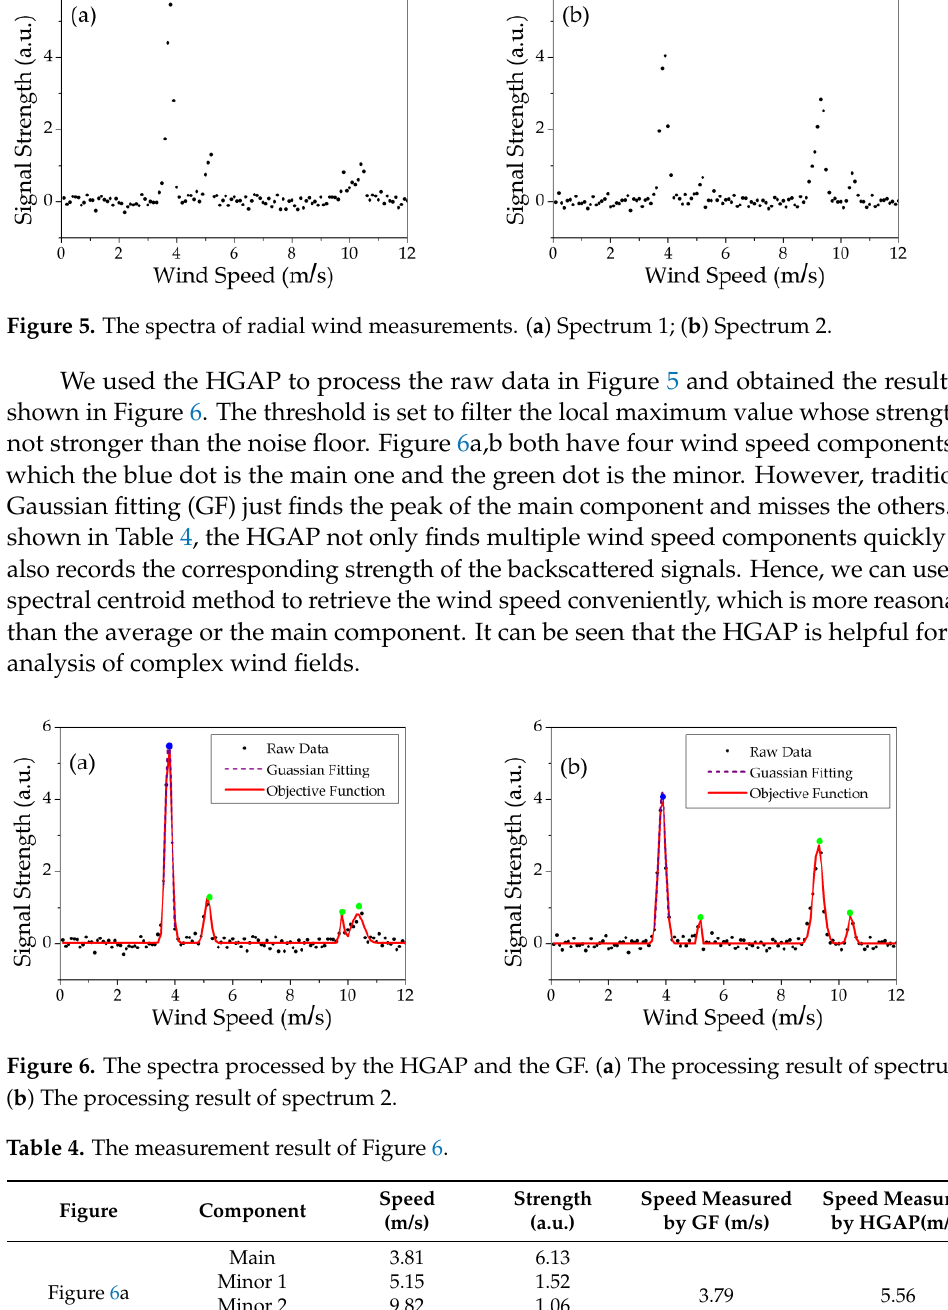
Figure 5. The spectra of radial wind measurements. ( a ) Spectrum 1; ( b ) Spectrum 2. Table 3. Key parameters of the CDWL.